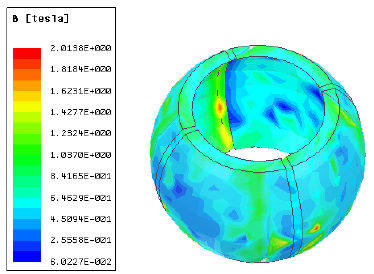
Figure 5. Pole magnetic field distribution of the generator. Figure 6. Magnetic dense cloud plot of the rotor. Figure 6. Magnetic dense cloud plot of the rotor.